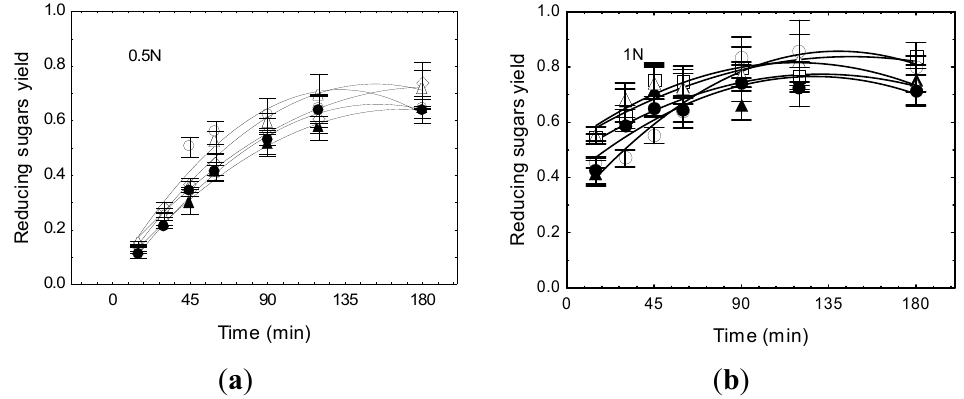
Figure 5. Reducing sugars yields (g glucose with acid mixtures ( Δ : 1.5:5.5:1; ○ : 2.5:4.5:1; □ : 3.5:3.5:1; ▲ : 4.5:2.5:1 and ● : 5.5:1.5:1) under 100 °C with total concentration of ( a ) 0.5 N and ( b ) 1 N. (Ratio means H SO :HNO :HCl). n = 9, bars are ± 2 4 3